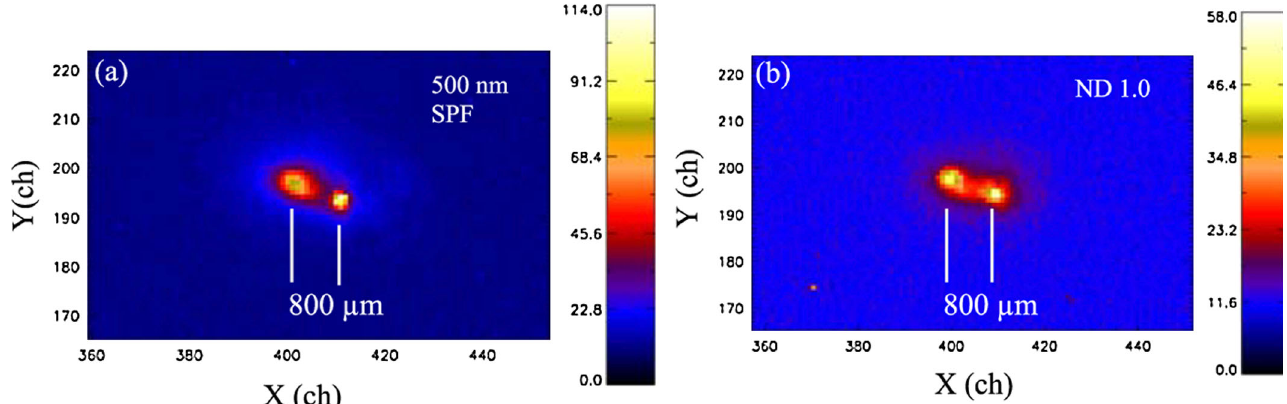
FIG. 10. (Color) Two examples of VLD1 OTR/COTR data with the 300-A beam for a 450-pC micropulse: (a) The image with 500-nm shortpass filter that blocks 530-nm SASE-related COTR. (There are two distinct peaks shown attributed to LSCIM) and (b) The SIM þ LSCIM COTR image with ND1.0 filter and no shortpass filter. One sees a similar two peaks, but with about 5 times more intensity.